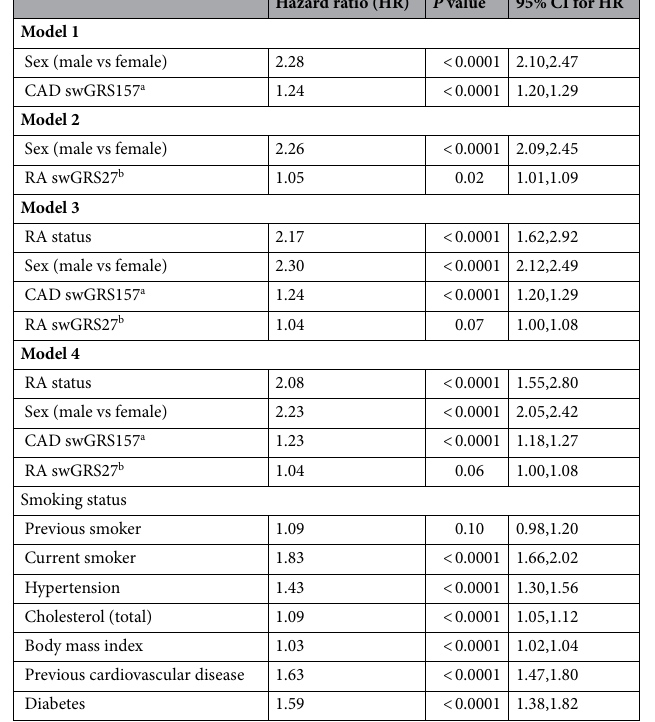
Table 2. Cox proportional hazards regression analysis for myocardial infarction. Number of participants: 61,465. Number of MI cases: 2609, as indicated for final dataset (Fig. 1). a CAD swGRS157: weighted genetic risk score for coronary artery disease based on 157 SNP used (Ref 25 ), standardized using standard deviation in the present population. b RA swGRS27: The best-fitting score for RA, developed previously (Ref 13 ), standardized using standard deviation in the present